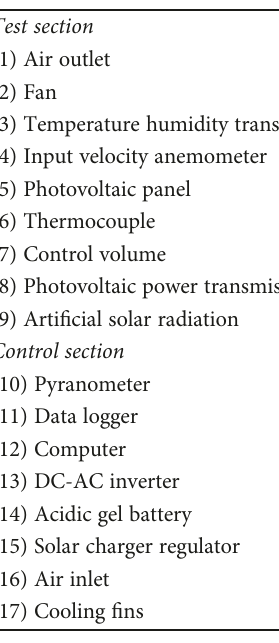
Table 2: Parts of the experimental